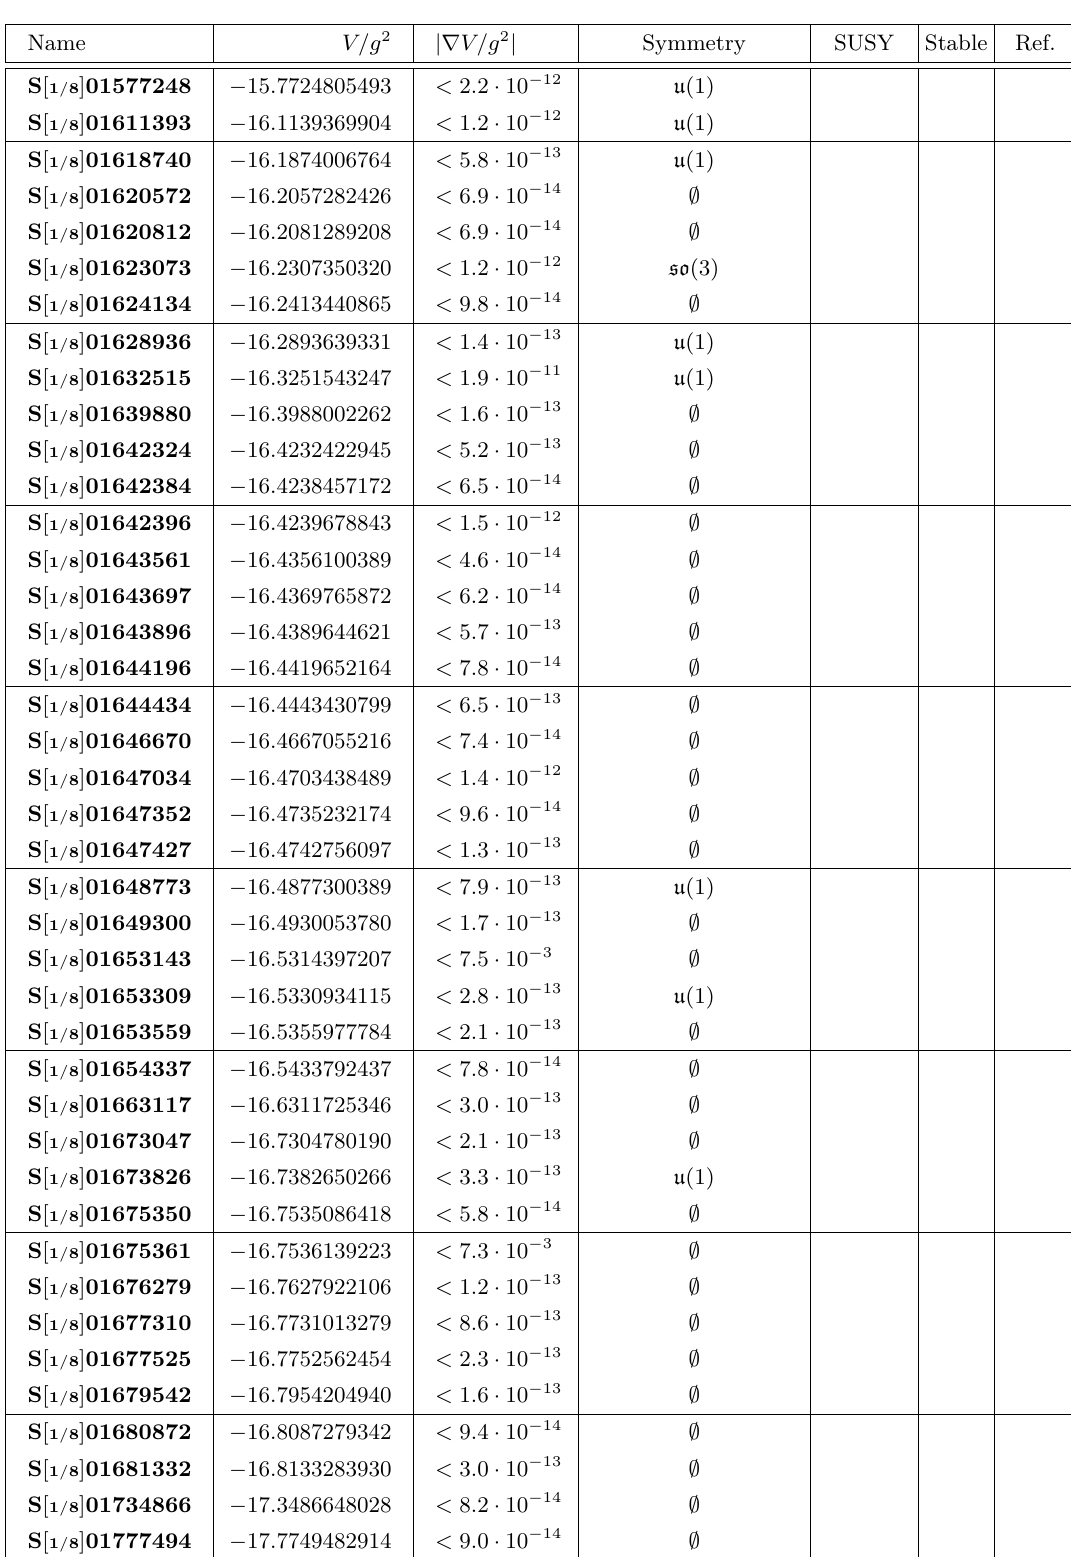
Table 1. Summary of vacua at ω = π/ 8